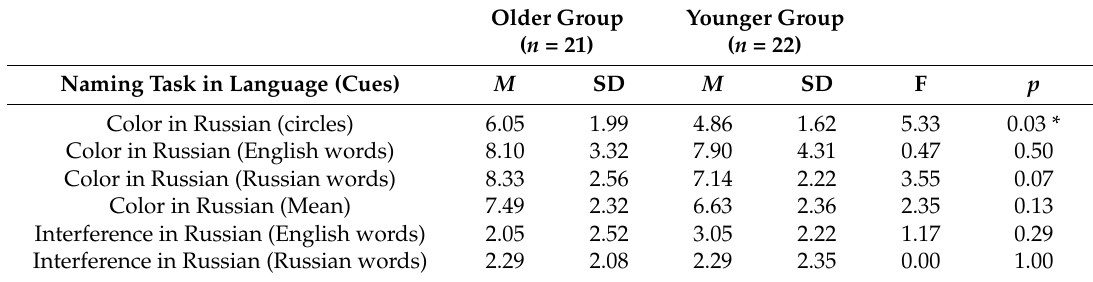
Table 6. Mean numbers of seconds needed to complete the color-naming tasks in Russian and English and interference effect scores by participants of the older group and the younger